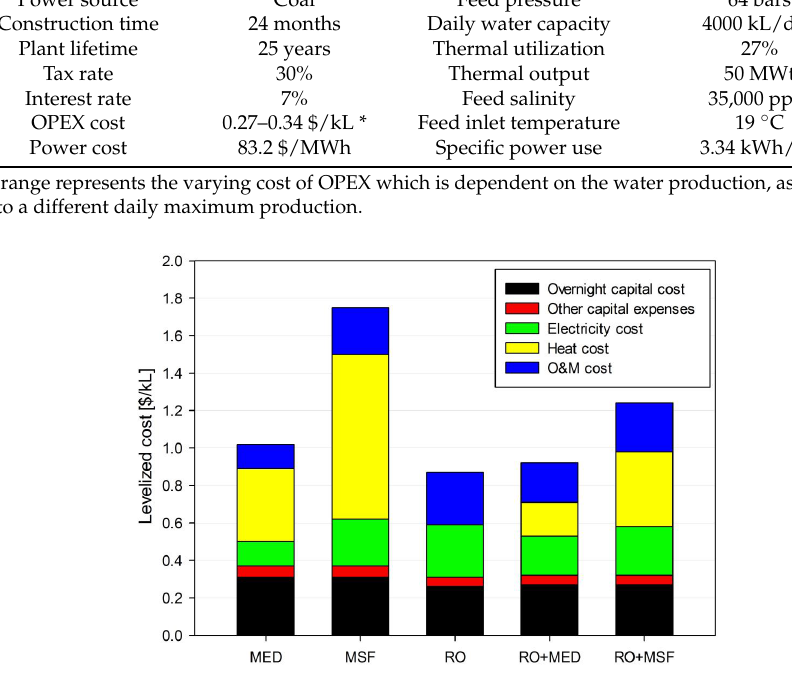
Figure 4. The cost comparison of different desalination technologies as calculated for 4 ML/day freshwater delivery to King Island. The two hybrid plants are modelled at 50% capacity for each desalination technology.